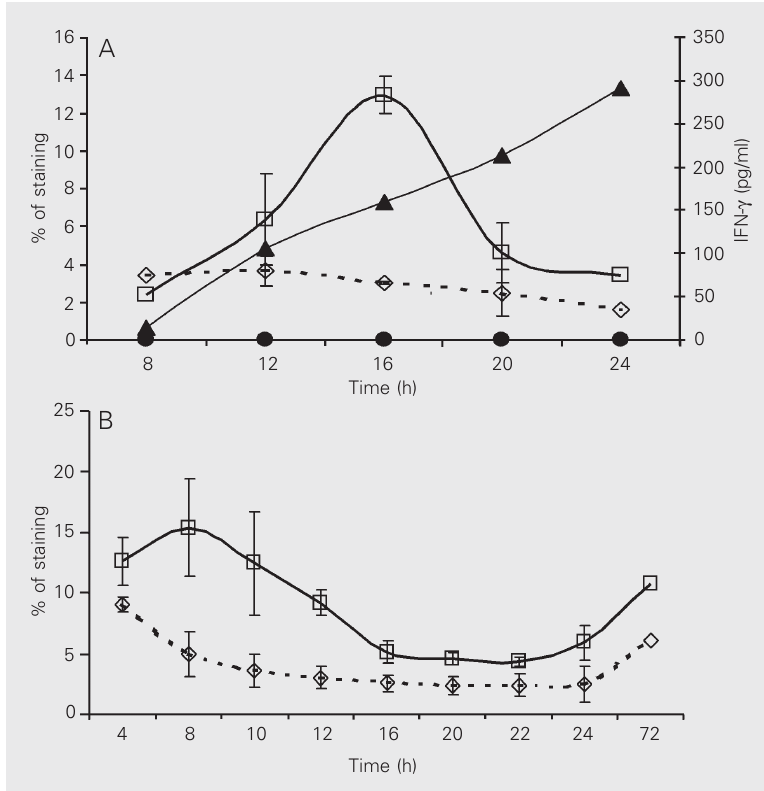
Figure 1. Kinetics of IFN- γ (A) and TNF- α (B) production by total lymphocytes from purified protein derivative- or Mycobacterium leprae -stimulated (squares) peripheral blood mono- nuclear cells of tuberculosis or leprosy patients, respectively. In A, a second axis on the right side of the figure denotes IFN- γ levels (pg/ml) from one representative tuberculosis patient culture supernatant comparing the same previous stimuli (circles) and where brefeldin A was suppressed (triangles). The dashed lines and diamonds indicate the non- stimulated cultures (medium). Data are reported as means ± SEM (N = 7) obtained from medium or Mycobacterium -antigens (at 10 µg/ml) plus cells additionally stimulated with PMA, ionomycin and brefeldin